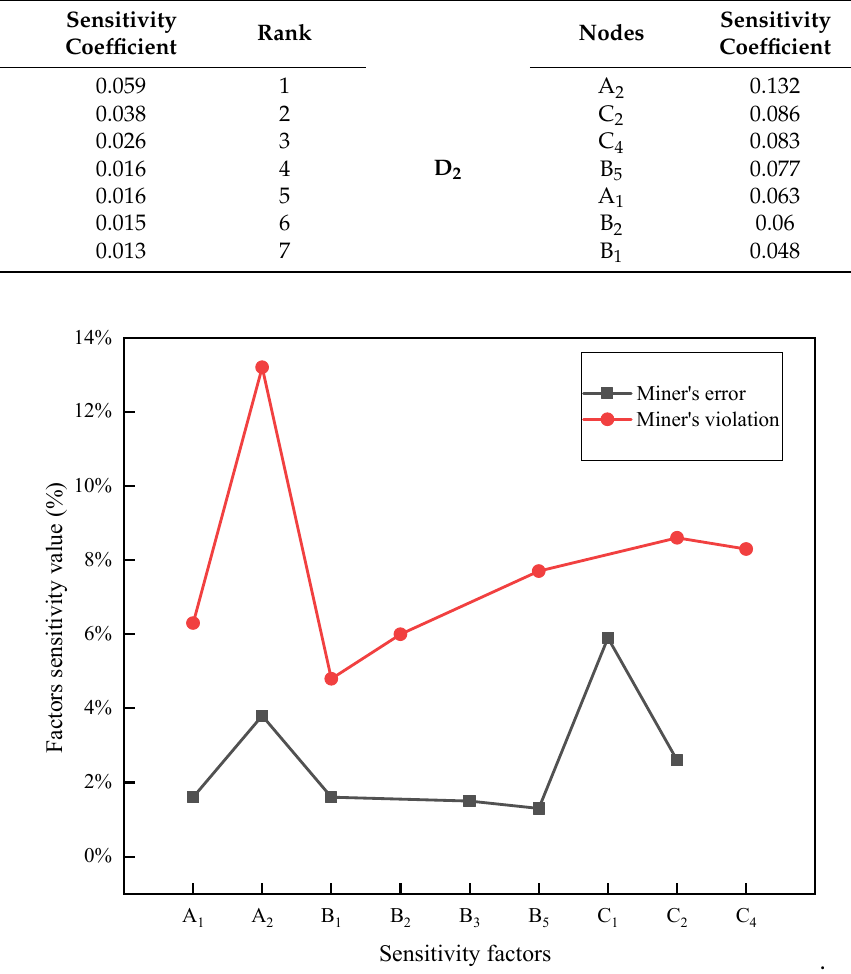
Figure 7. Sensitivity coefficient distribution diagram.